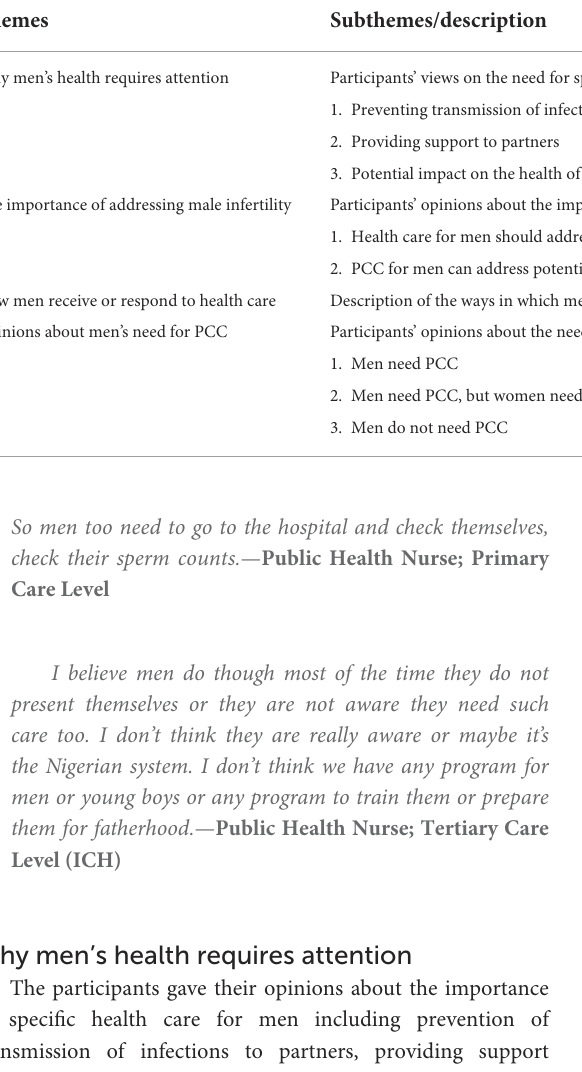
TABLE 3 Themes derived from the